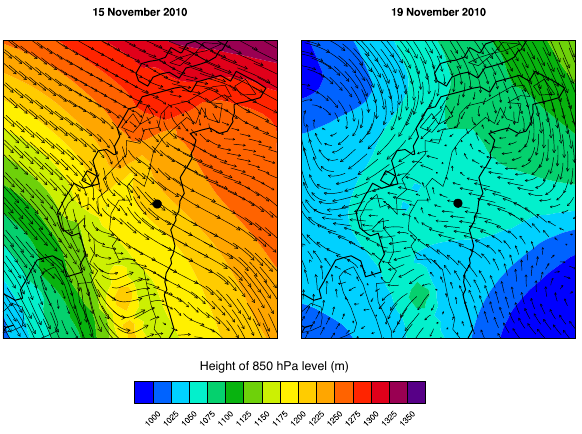
Fig. 12. Surface wind speed and direction (vectors) and the height of the 850hPa level from RACMO2, for (a) 15 November 2010 and (b) 19 November 2010. The location of AWS 14 is denoted with the black